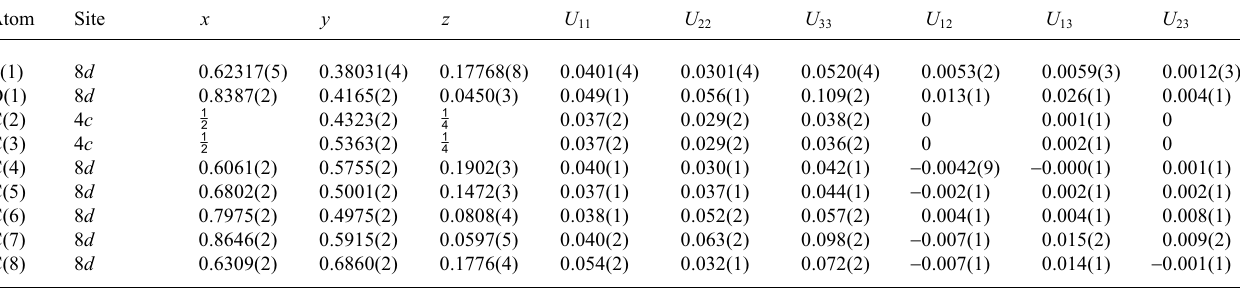
Table 3. Atomic coordinates and displacement parameters (in Å 2 )